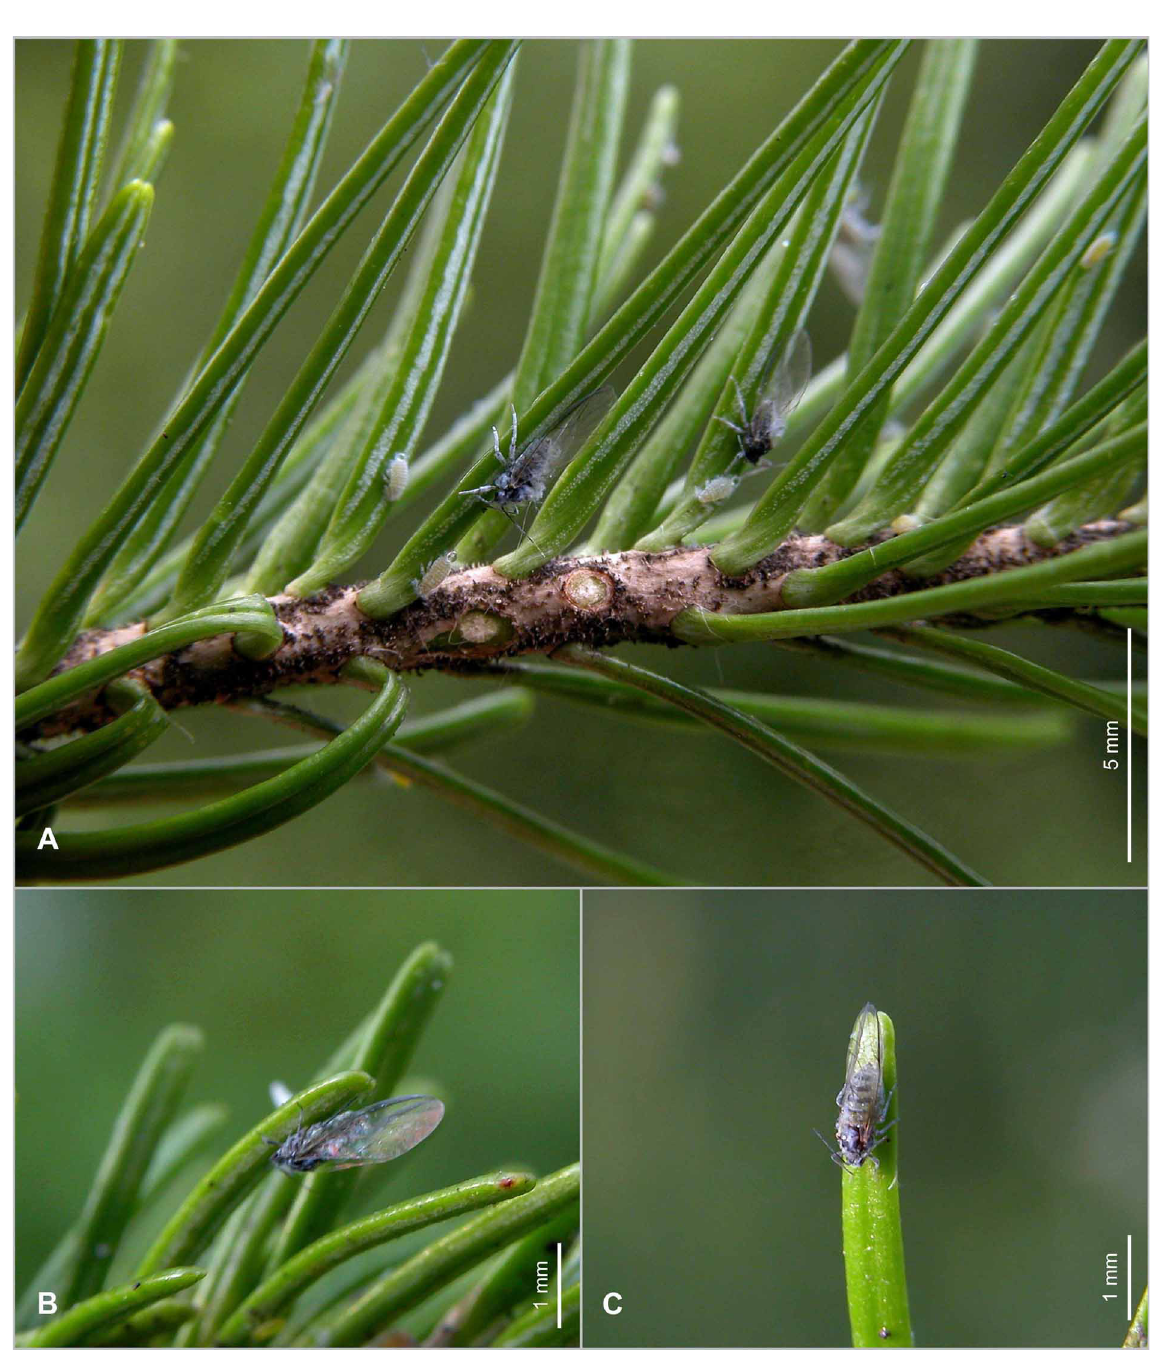
Fig. 49. Mindarus abietinus (Koch, 1857). Adult alatae and young oviparae on needles of Abies